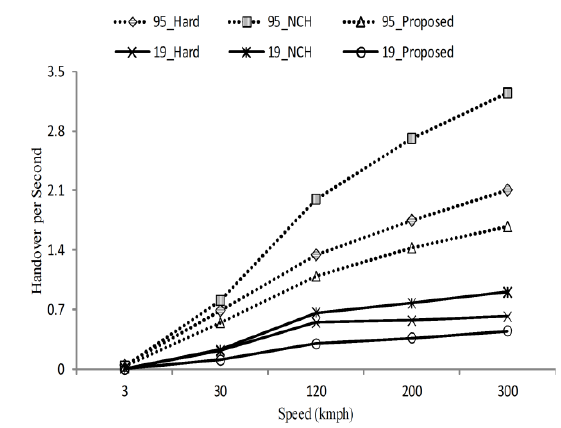
Fig. 7. The comparison of the number of handovers per